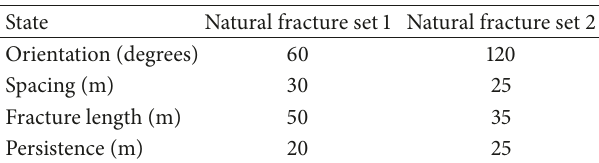
Table 4: Natural fracture sets of naturally fractured